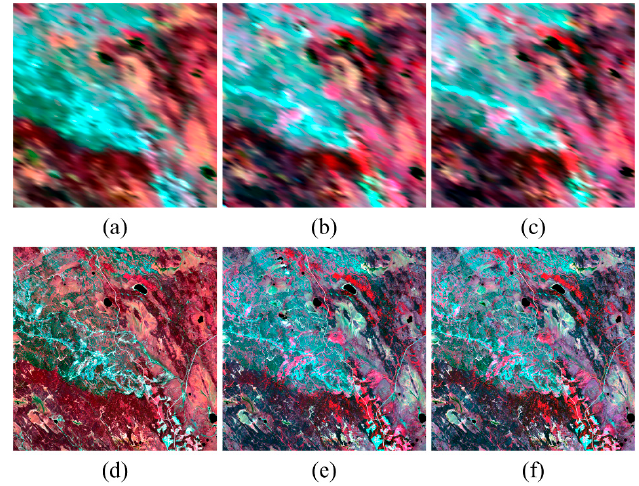
Figure 5. NIR–green–blue composites of the MODIS imagery ( upper row ) and Landsat imagery ( lower row ) taken on ( a , d ) 24 May 2001, ( b , e ) 11 July 2001, and ( c , f ) 12 August 2001, respectively.